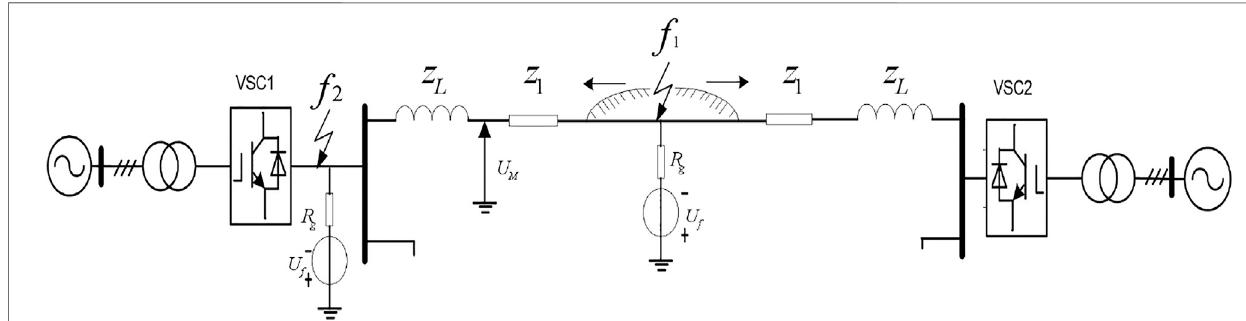
FIGURE 2 | Schematic diagram of line fault voltage traveling wave propagation.